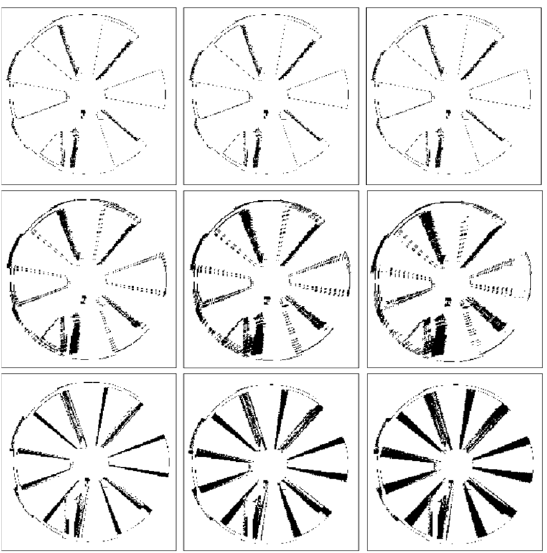
Figure 9. Siemens Star that is parallel to the image plane of the ToF sensor without motion ( top ), with synthetic motion blur ( middle ), with real motion blur ( bottom ) at 60 RPM ( left ), 100 RPM ( center ), and 135 RPM ( right ).